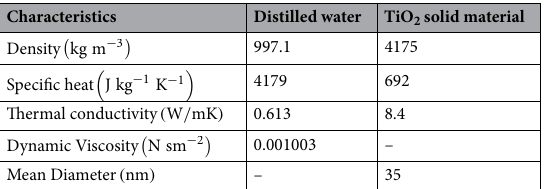
Characteristics